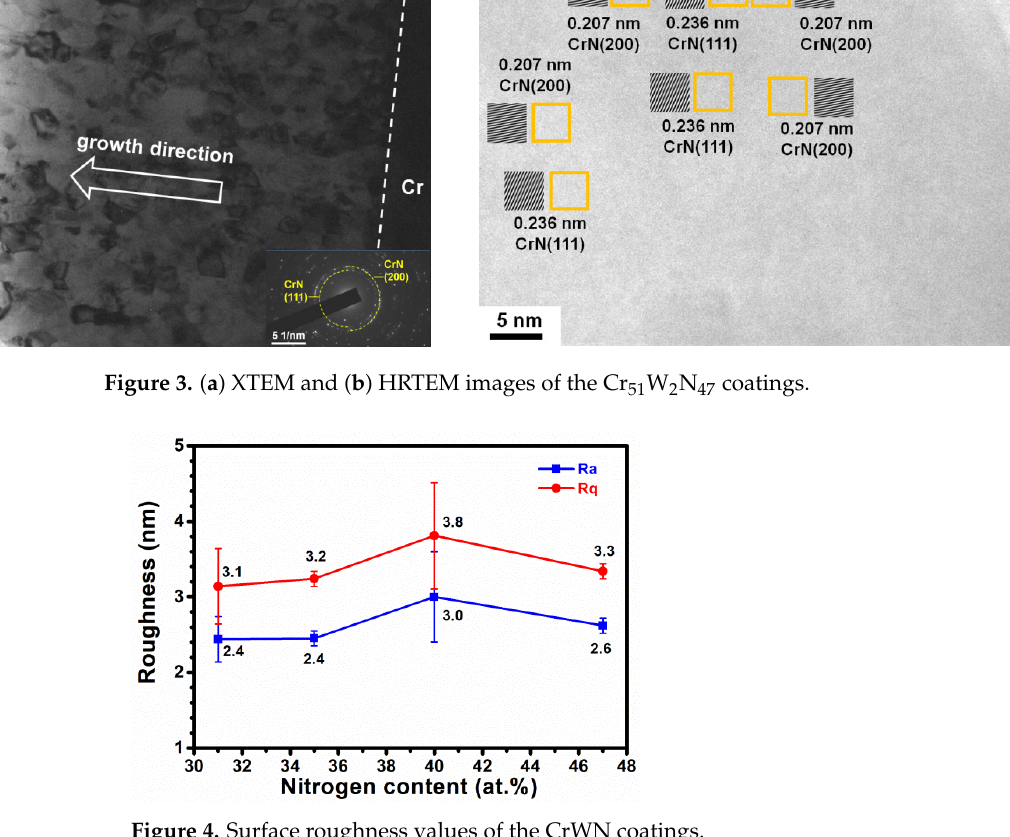
Figure 4. Surface roughness values of the CrWN coatings.